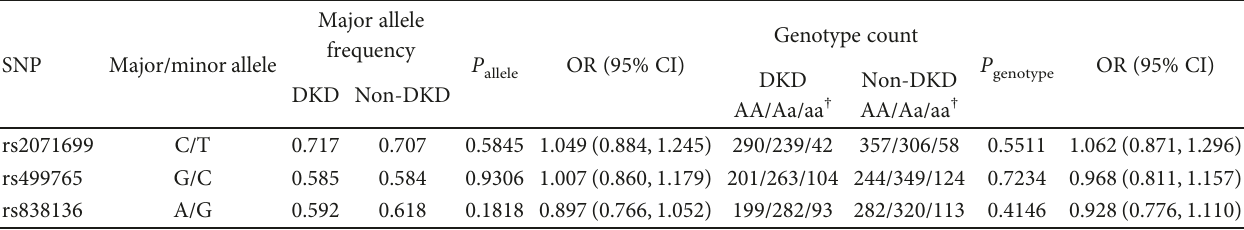
Table 3: Associations between SNPs and DKD susceptibility in type 2 diabetic patients.